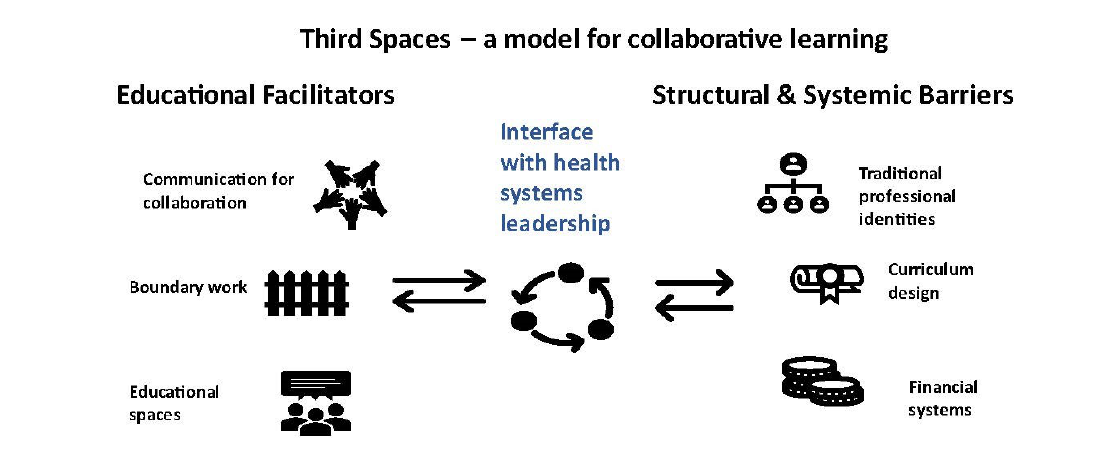
Figure 2. Model for collaborative learning in third spaces (Source: